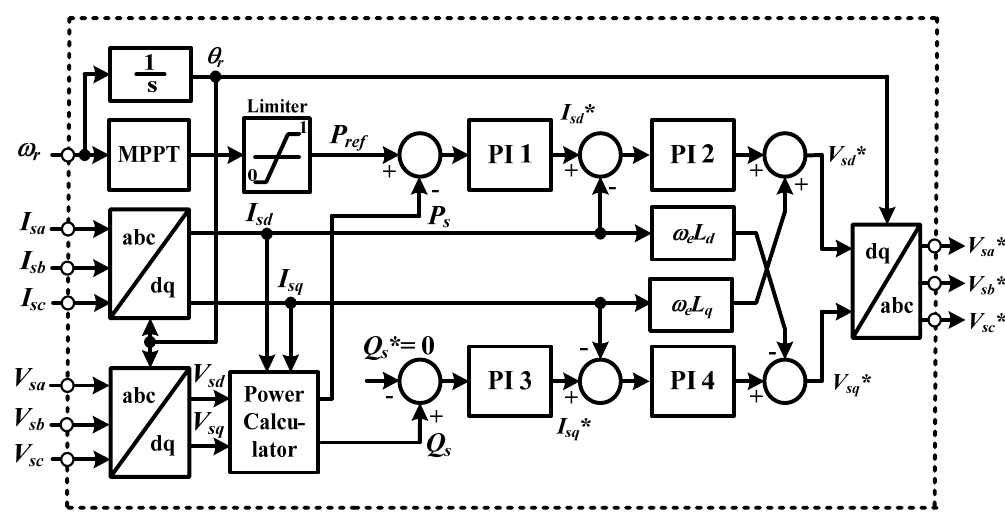
Figure 7. Stator side controller system.